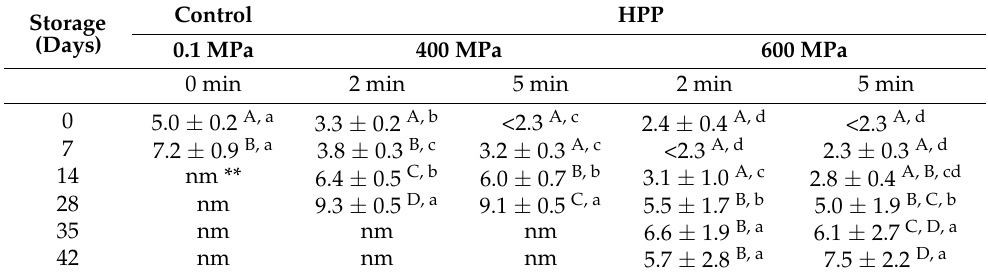
* Each value in the table is the mean ± standard deviation (n = 9). The capital letters (A, B, C, and D) indicate a significant difference ( p < 0.05 multiple Tukey’s adjusted analyses of variance) within the same treatment and days (same column). Small letters (a, b, c, and d) indicate a significant difference ( p < 0.05) between different treatments (same row). The detection level was 2.3 log cfu/g. Where no survival was detected, the values were set to 50% of the detection limit. ** Not